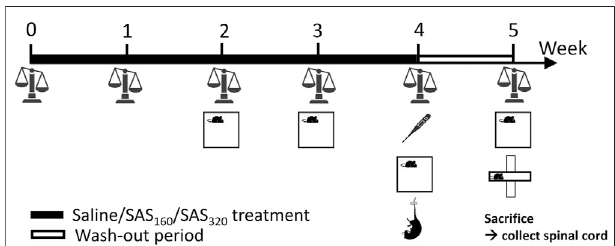
FIGURE 1 | Graphical illustration of the experimental design. Over a period of four weeks, mice were treated with SAS (or saline), followed by a wash-out period of one week. Every week, the body weight of the mice was measured and starting from the second week of treatment, effects of SAS on locomotor function and anxiety-like behavior were analyzed using the open fi eld test (OF). After four weeks of treatment, we evaluated the effect of SASonbodytemperatureaswellasdepressive-likebehaviorusingthemouse tail suspension test. At the end of the wash-out period, long-lasting effects of SASonbodyweight,locomotorfunctionandanxiety-likebehavior(usingtheOF as well as the elevated plus maze test) were studied. After behavioral testing, mice were sacri fi ced and the spinal cord was harvested for further